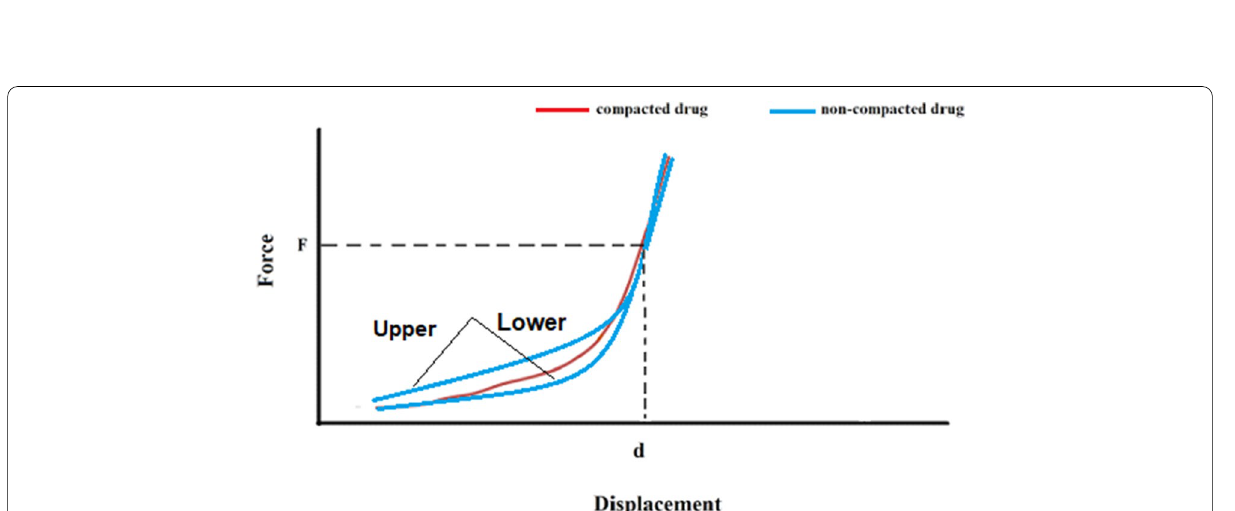
Fig. 11 A sketch representing the effect of changing Kawakita parameters ( P k and a ) on the position of the F-D curve in accord with Eq. 2 when there is no remarkable difference in the maximum volume reduction for both higher and lower initial F-D profiles of compacted than non-compacted